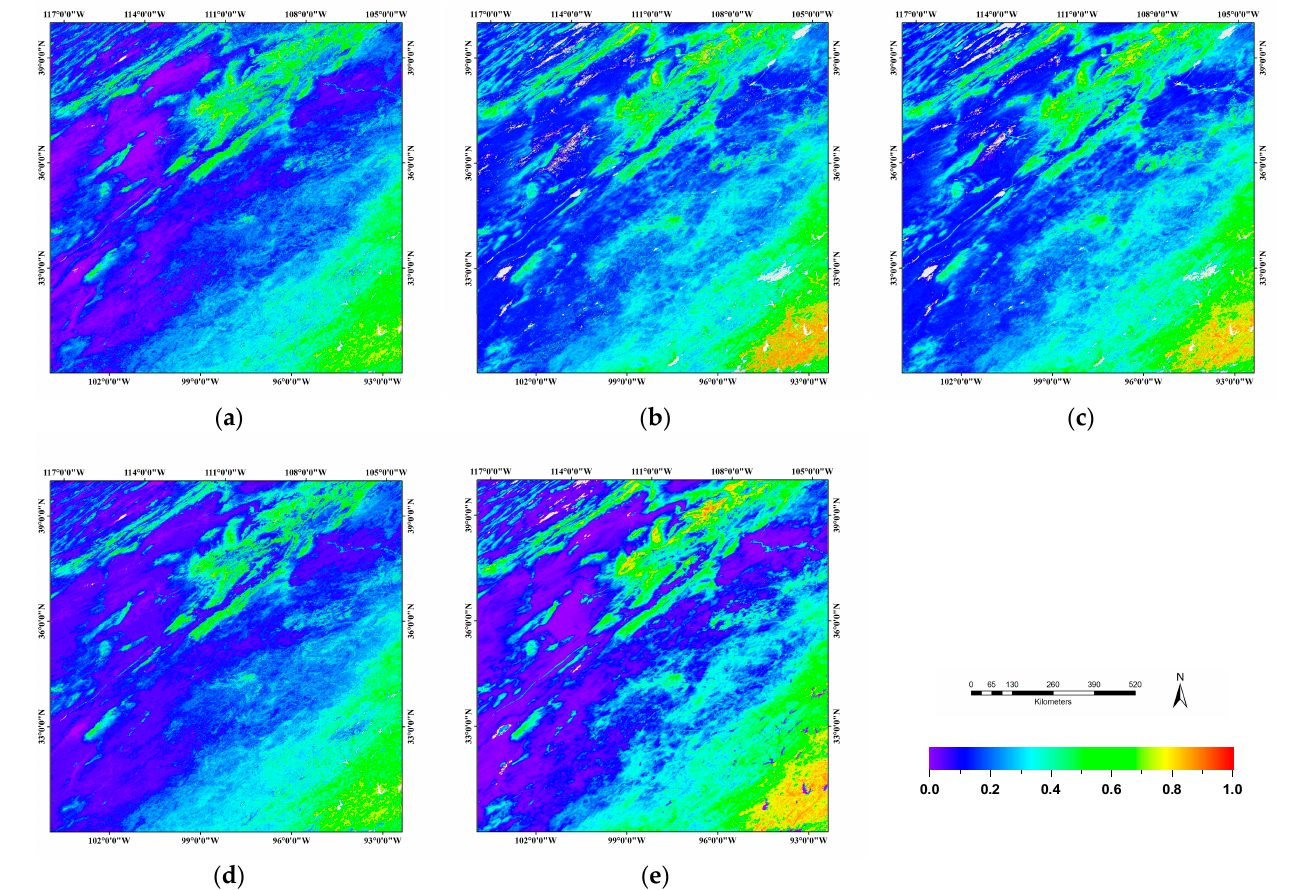
Figure 5. Maps of ( a ) VIIRS; ( b ) MODC5; ( c ) MODC6; ( d ) GLASS; and ( e ) GEOV1 FAPAR products for tile h09v05 on day 185, 2013. White color denotes water, and areas masked in grey correspond to pixels where these FAPAR products did not provide valid FAPAR values.